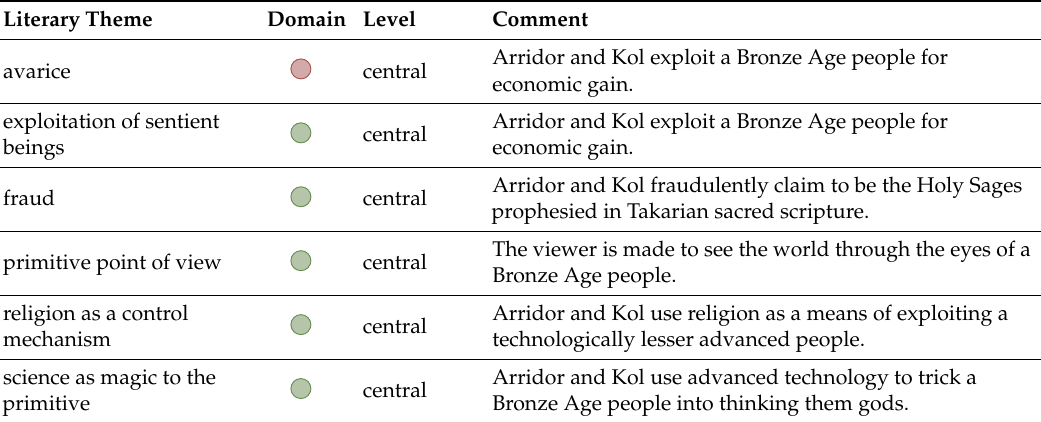
Table A1. Inventory of the Star Trek: Voyager episode False Profits (1996) themes. The domain color-codes are red for “the human condition”, green for “society”, yellow for “alternate reality”, and blue for “the pursuit of